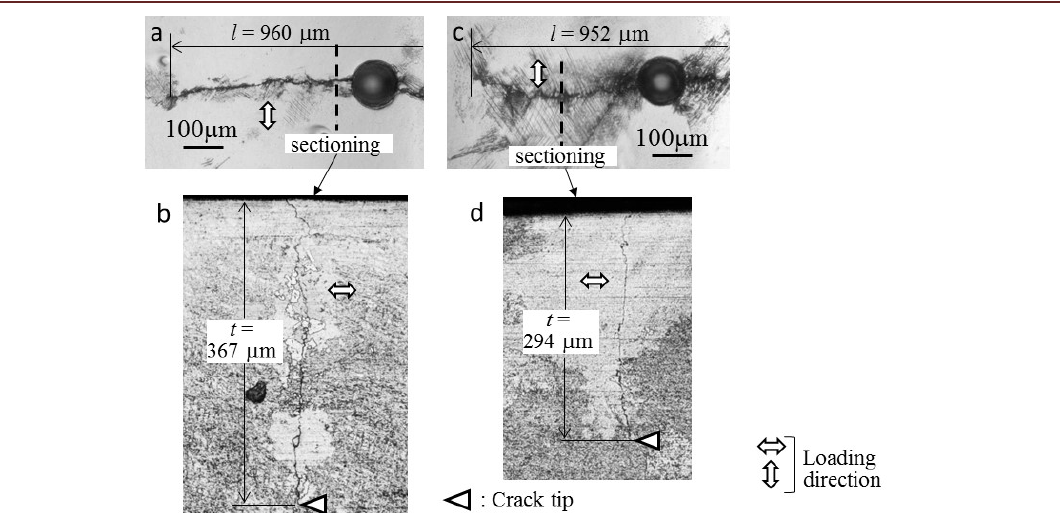
Figure 5: Crack paths at  a = 90 MPa: (a and c) sectioning position described in the crack paths of the zx - and xy -planes; (b and d) crack paths in the sectioned plane for the zx - and xy -plane cracks.